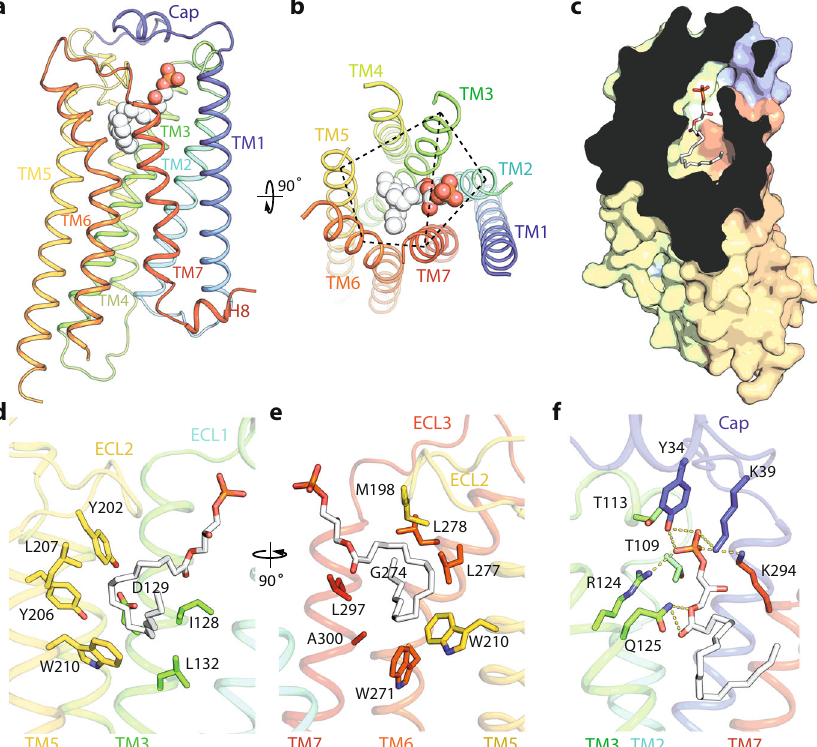
Fig. 3 The orthosteric LPA-binding pocket of the active LPA 1 . a , b Cartoon representation of LPA 1 with the bound LPA in spheres, and rotated 90° to show the two binding modules of transmembrane (TM) helices indicated by dashed lines. c Slice through view of the LPA-binding pocket. d – f Residues involved in interacting with the hydrocarbon chain ( d , e ) or the polar head group ( f ) of LPA are shown in sticks.